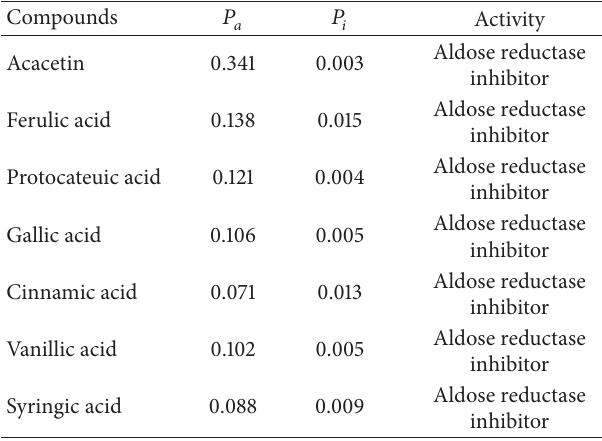
Table 4: The results of statistical aldose reductase inhibition activity predictions of the polyphenols using PASS.